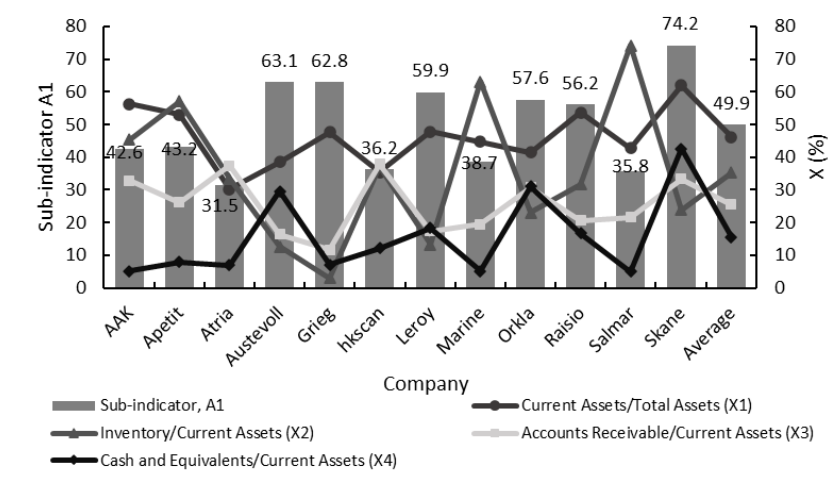
Fig. 4. The average values of components of the sub-indicator of current assets (A1) of food companies from Northern Europe in